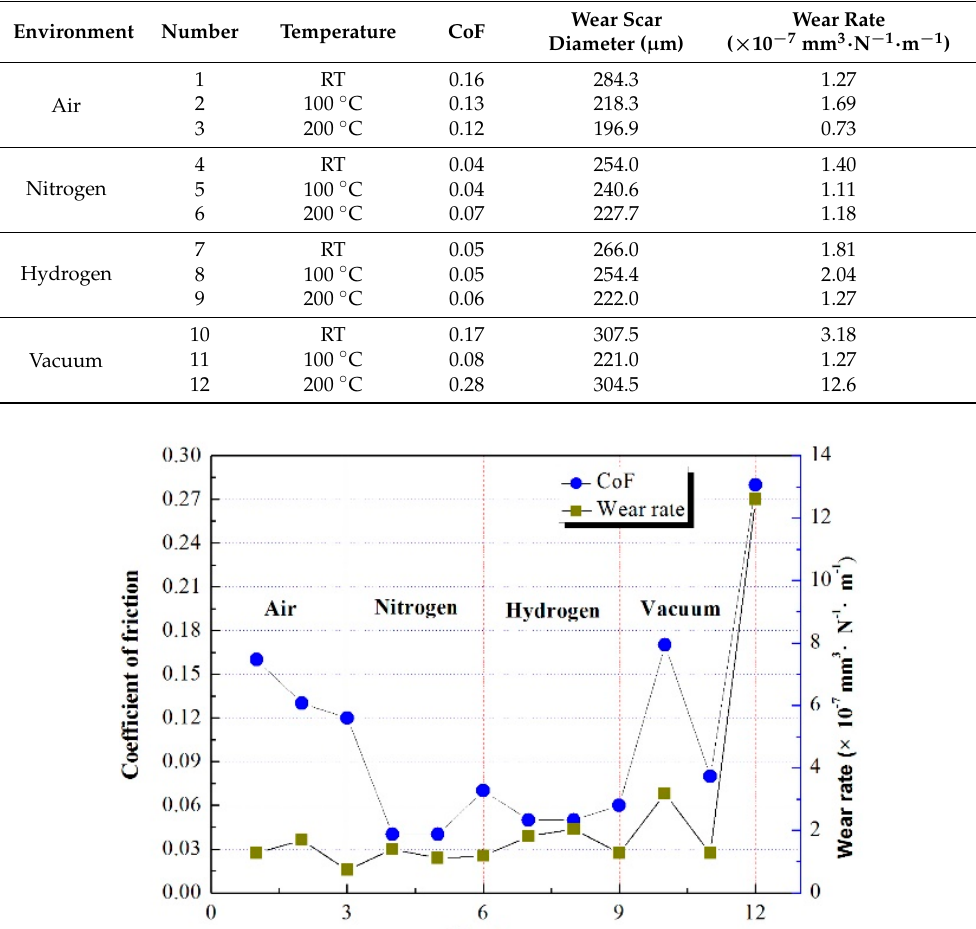
Table 1. Average CoF and the diameter of wear scar of the ball.